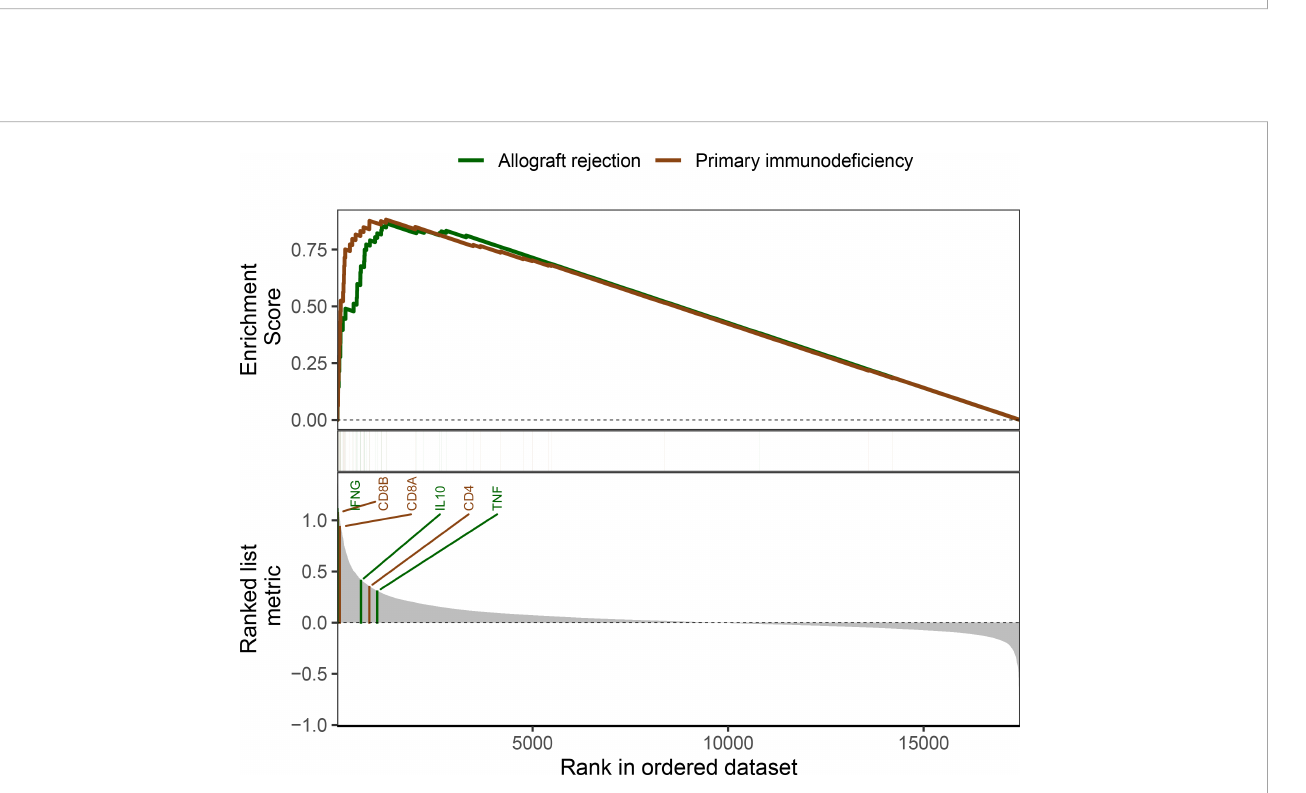
FIGURE 7 GSEA of signaling pathways between two risk